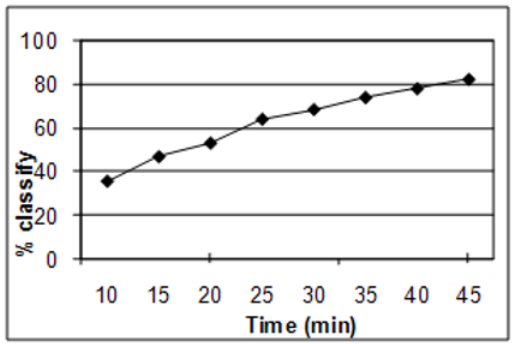
Fig. 3. Curve (3): Variation of class < 74µm according to